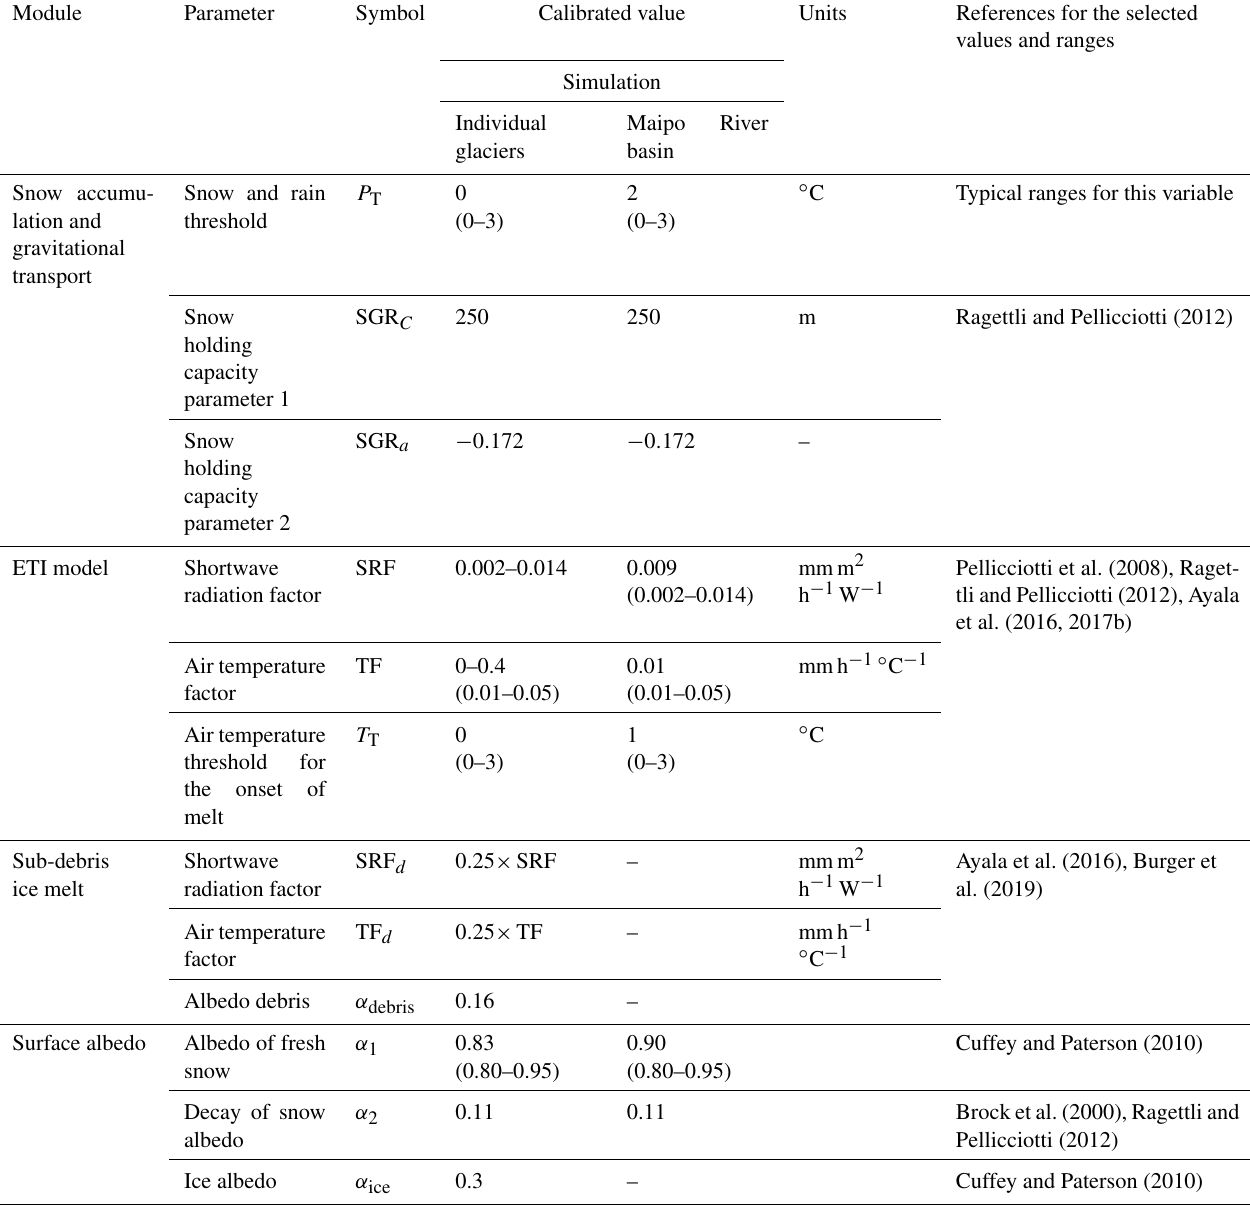
Table 1. Parameters in TOPKAPI-ETH’s snow and ice modules for the 1955–2016 time period. The tested ranges of some parameters are given in